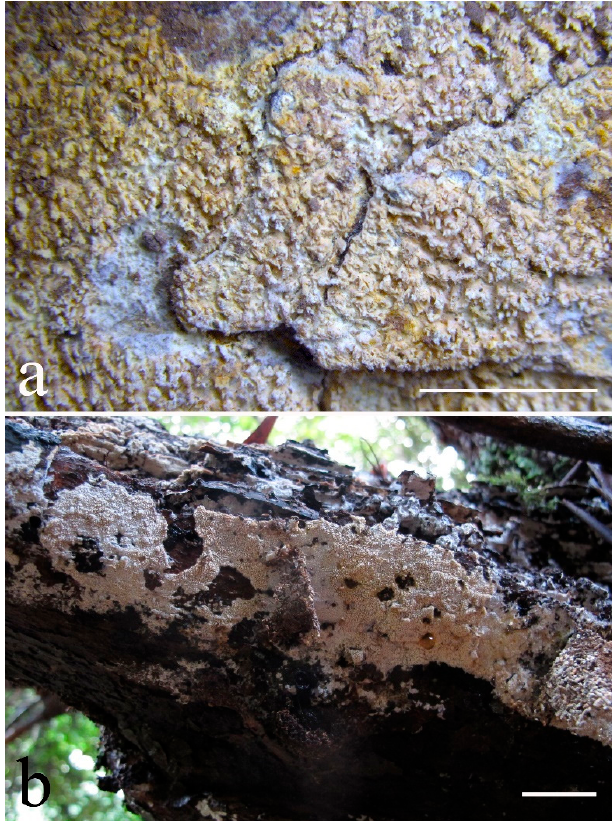
Figure 28. Basidiocarps of Xylodon rhododendricola (LWZ 20180512-4, holotype).—Scale bars: a = 5 mm; b = 2 cm.